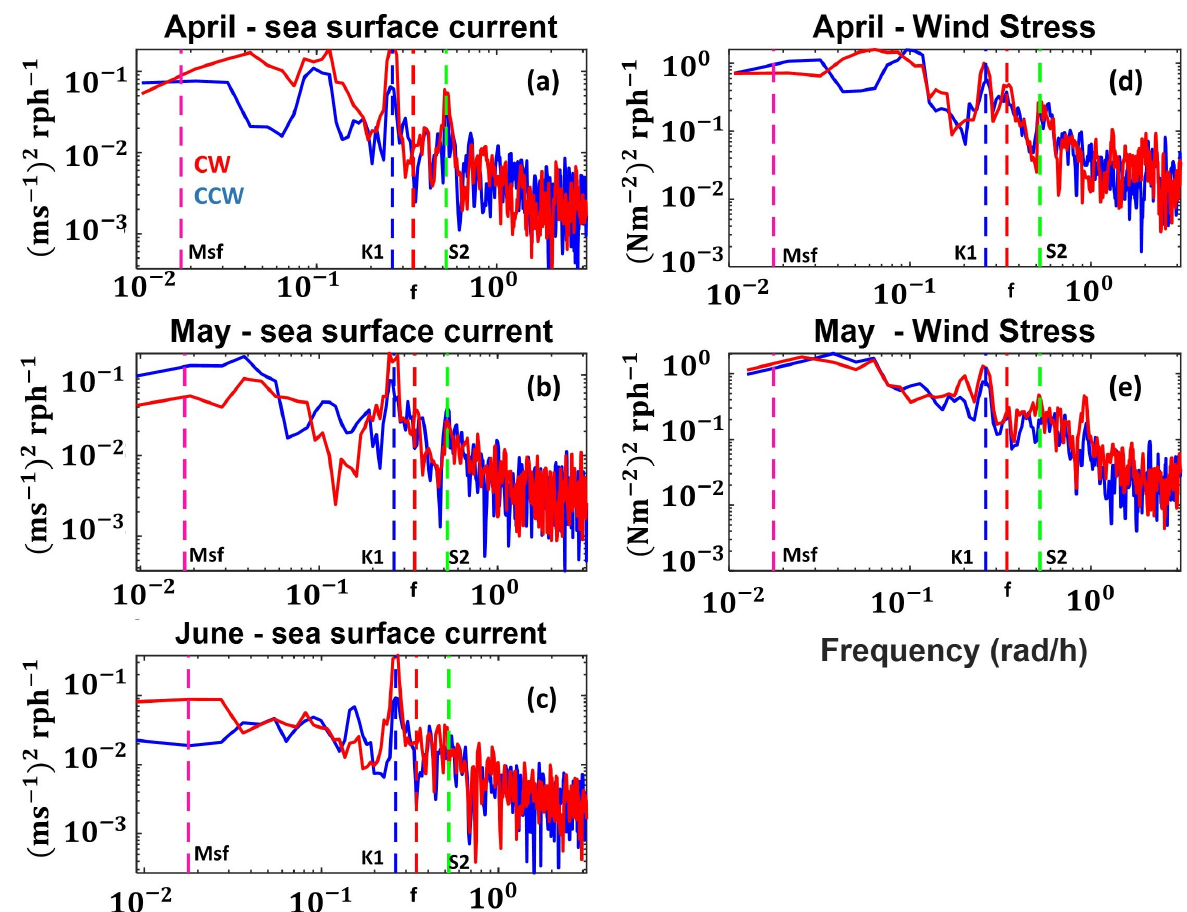
Figure 6. Clockwise (red) and counterclockwise (blue) spectra for observed hourly surface current and wind stress data for April ( a , d ), May ( b , e ) and June ( c ). The tidal constituents (K1: blue vertical dashed line; S2: green vertical dashed line; f: red vertical dashed line; Msf: violet vertical dashed line) are evidenced on the frequency axis.